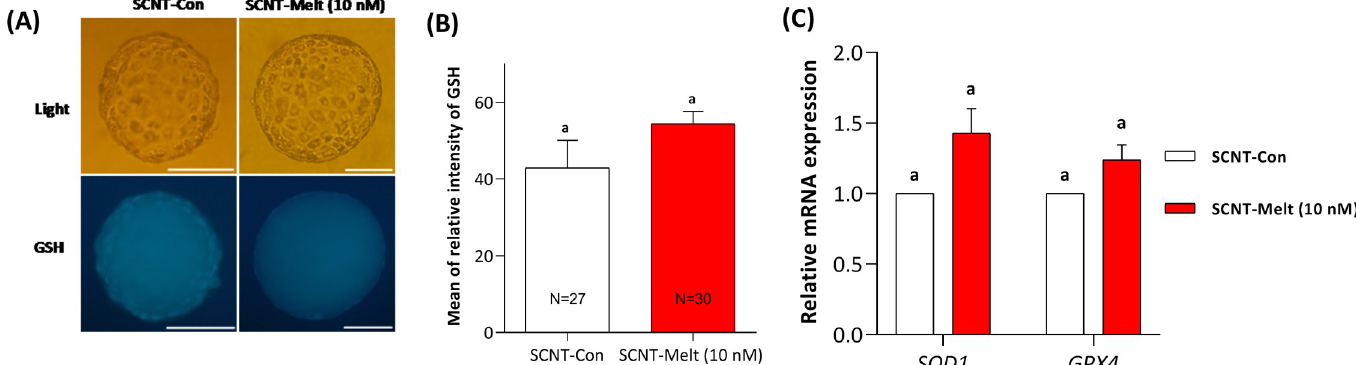
Fig 3. Effect of melatonin on GSH level of ovine SCNT blastocysts and the relative mRNA expression of regulating enzymes. A) Fluorescent images of glutathione content in ovine SCNT blastocysts in control and melatonin-treated groups assessed by Cell Tracker Blue. Scale bar, 100 μ m B) The mean of relative fluorescent intensity of GSH in ovine SCNT blastocyst. C) The relative mRNA expression level of antioxidant genes ( SOD 1 and GPX4 ) in SCNT-Melt (10 nM) and SCNT-Con groups. The data were shown as mean ± SEM. Values with different letters have a statistically significant difference ( P < 0.05).